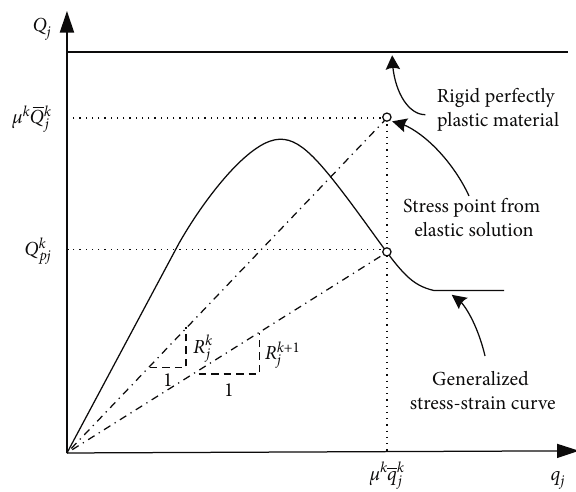
Figure 2: Schematic representation of the linear matching